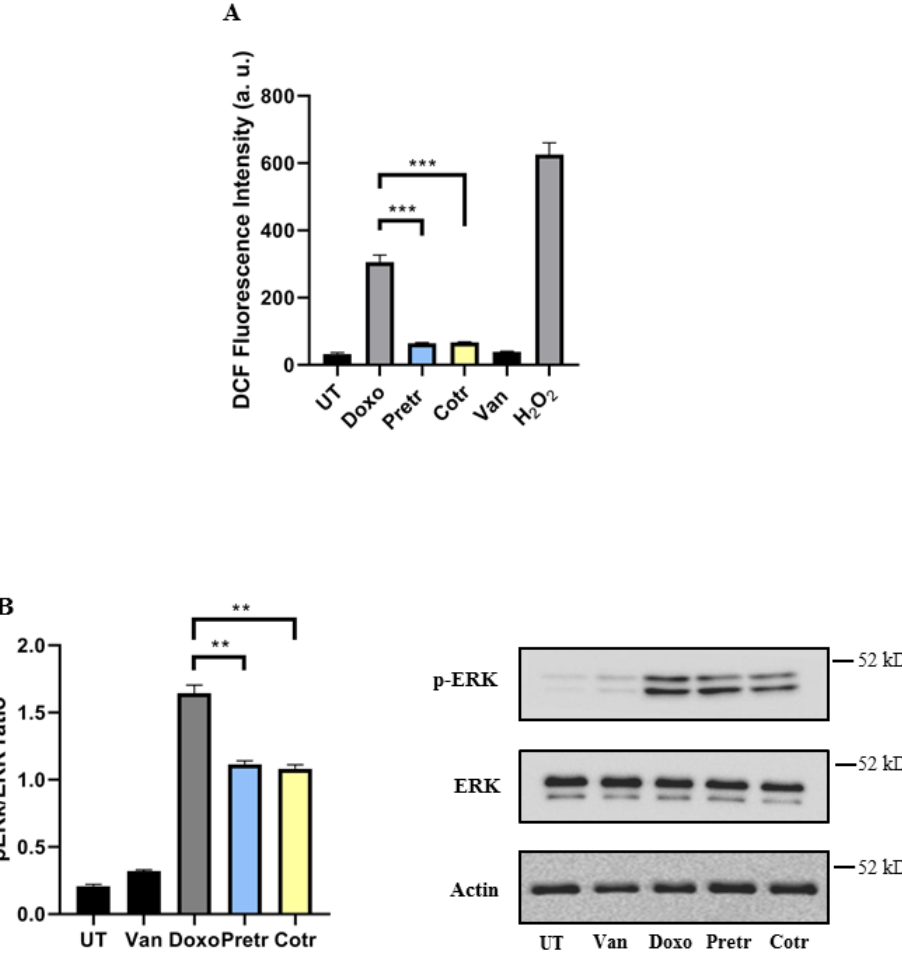
Figure 6. E ff ect of vanillin on doxo-induced ROS production and MAPK signaling. ( A ) ROS production Figure 6. Effect of vanillin on doxo-induced ROS production and MAPK signaling. ( A ) ROS was evaluated by DCFHDA assay in H9c2 cells exposed to 20- µ M doxo for 24 h, pretreated (Pretr) and production was evaluated by DCFHDA assay in H9c2 cells exposed to 20-μM doxo for 24 h, co-treated (Cotr) with 100- µ M vanillin. The data are presented as mean ± SD of three replicates in five pretreated (Pretr) and co-treated (Cotr) with 100-μM vanillin. The data are presented as mean ± SD of independent experiments; ( B ) western blot analysis of ERK activation. The image is representative three replicates in five independent experiments; ( B ) western blot analysis of ERK activation. The of western blotting from two di ff erent cellular extract with similar results. UT—untreated cells; image is representative of western blotting from two different cellular extract with similar results. doxo—cells exposed to 20- µ M doxo; Van—cells exposed to 100- µ M Van; H 2 O 2 —cells treated with 1-mM H 2 O 2 ; ** p < 0.01; *** p < 0.001, by one-way ANOVA. Other experimental details are described